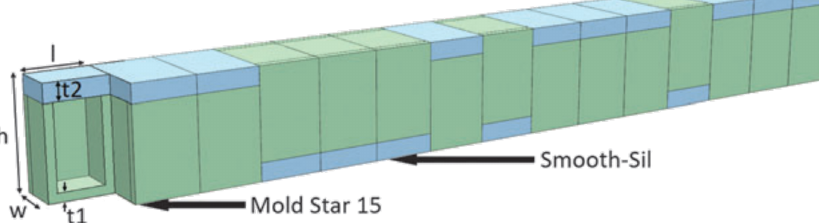
Figure 2. Example of a 15-unit pneumatic network bending actuator, showing the geometric parame- ters of a single representative unit. Regions cast in Mold Star 15 are shown as green, and Smooth- Sil 950 as blue. Units with the Smooth-Sil 950 strain limiting layer on top are in the ‘up’ position, and those with the strain limiting layer at the bottom are in the ‘down’